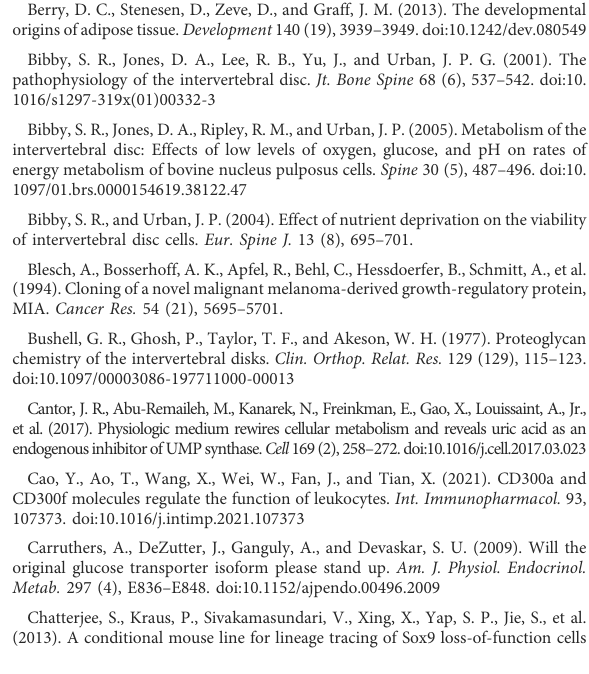
SUPPLEMENTARY FIGURE S2 TopthreeGeneOntology(GO)categoriesafterfunctionalenrichmentfor molecular or biological